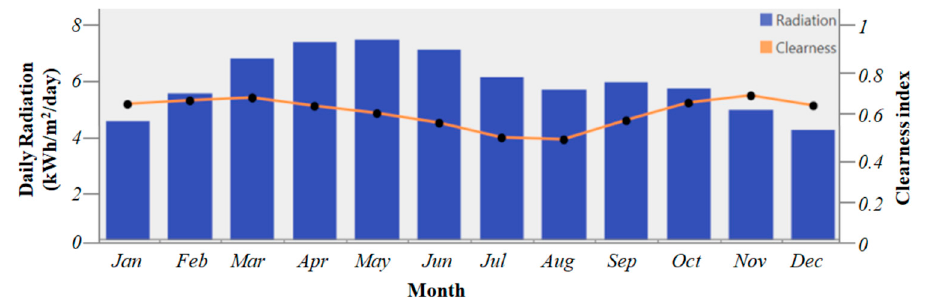
Figure 7. Solar radiation and clearness index of the selected location.